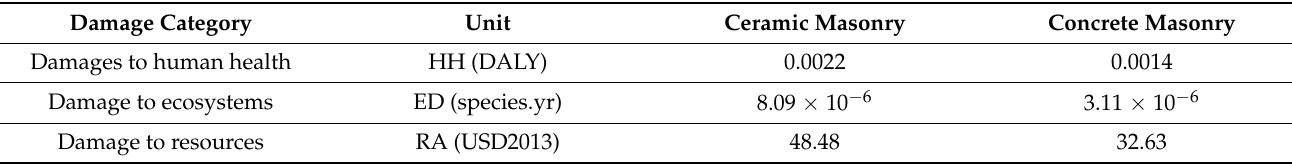
Table 7. Environmental damages per m 2 of